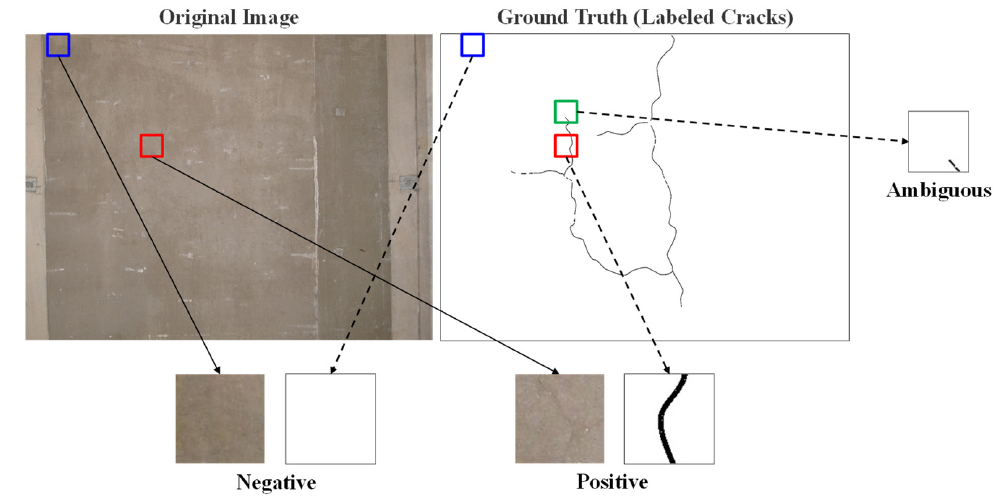
Figure 4. Labeling Cracks on Original Images and Classifying Square